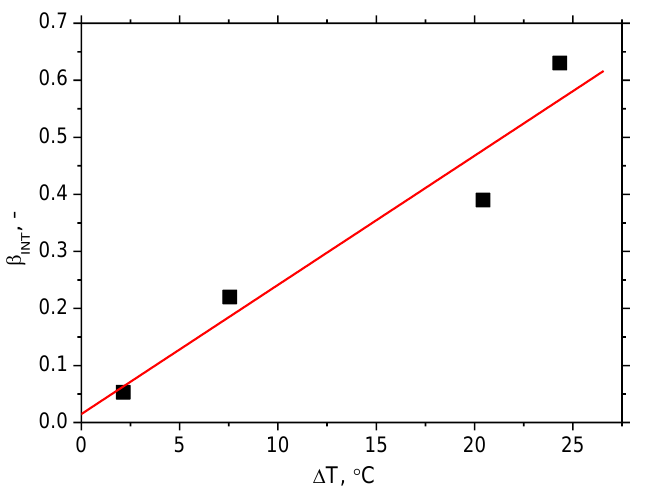
Figure 7. Evolution of β INT as a function of plastic strain and strain rate at the end of the test.